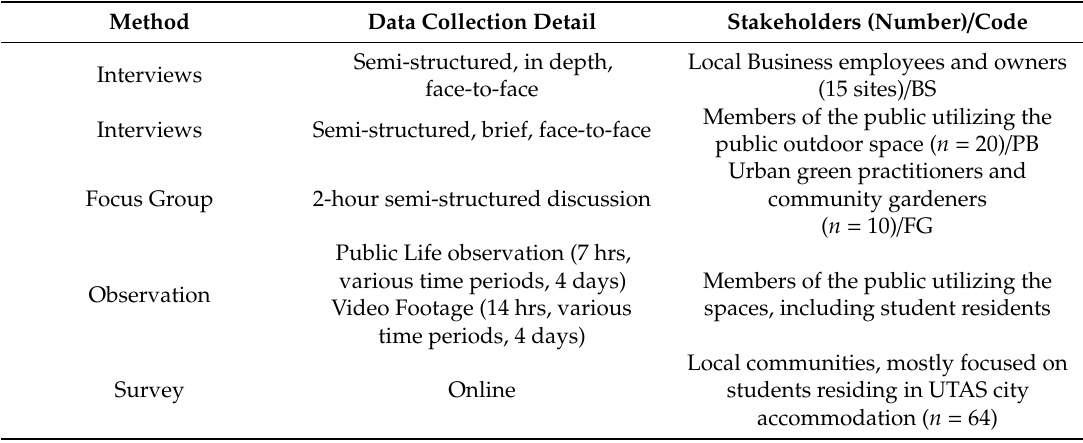
Table 1. Study methods with the associated data collection process and relevant